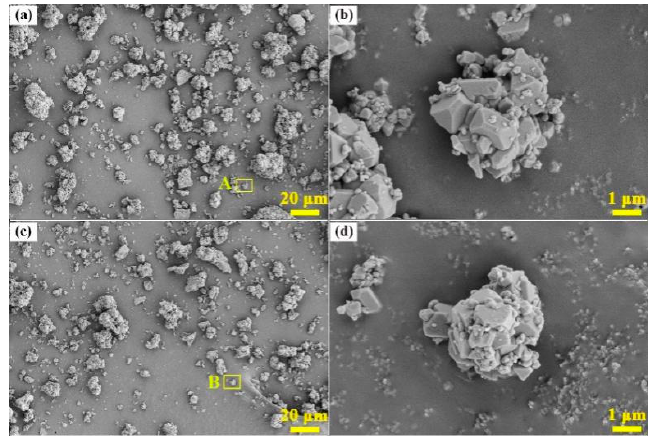
Figure 14. SEM micrographs of ( a ) commercial cryolite, ( b ) enlarged image of the area A marked in ( a ), ( c ) as-synthesized cryolite, and ( d ) enlarged image of the area B marked in ( c ).